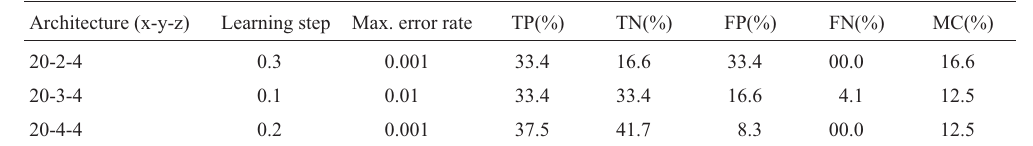
Table 2 - Comparison between the first model networks. The column Architecture(x-y-z) indicates the number of units in the input, hidden, and output layers, respectively. The column MC (Misclassified) indicates that the network correctly classified a sequence as a RBS, but in the wrong cluster. Architecture (x-y-z)